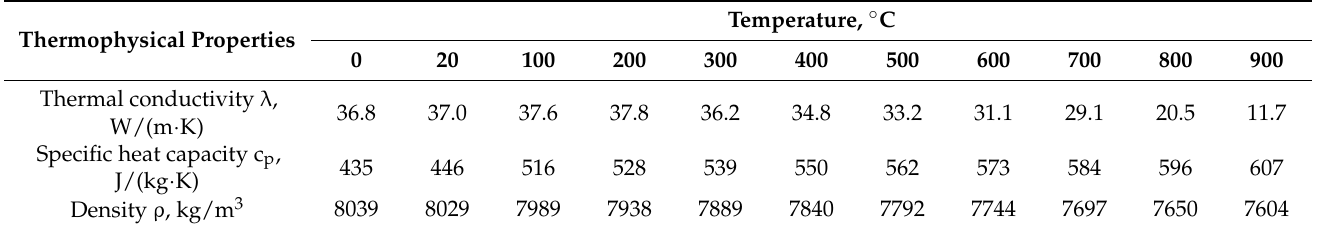
Table 3. Thermophysical properties used in SYSWELD.